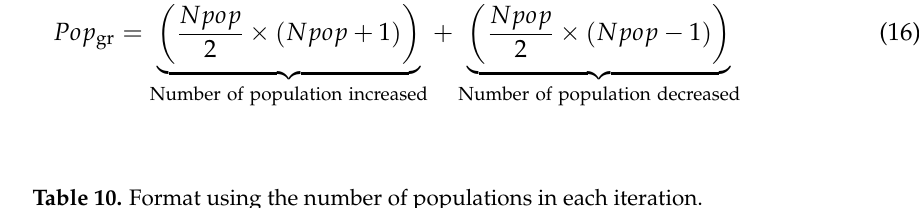
Table 10. Format using the number of populations in each